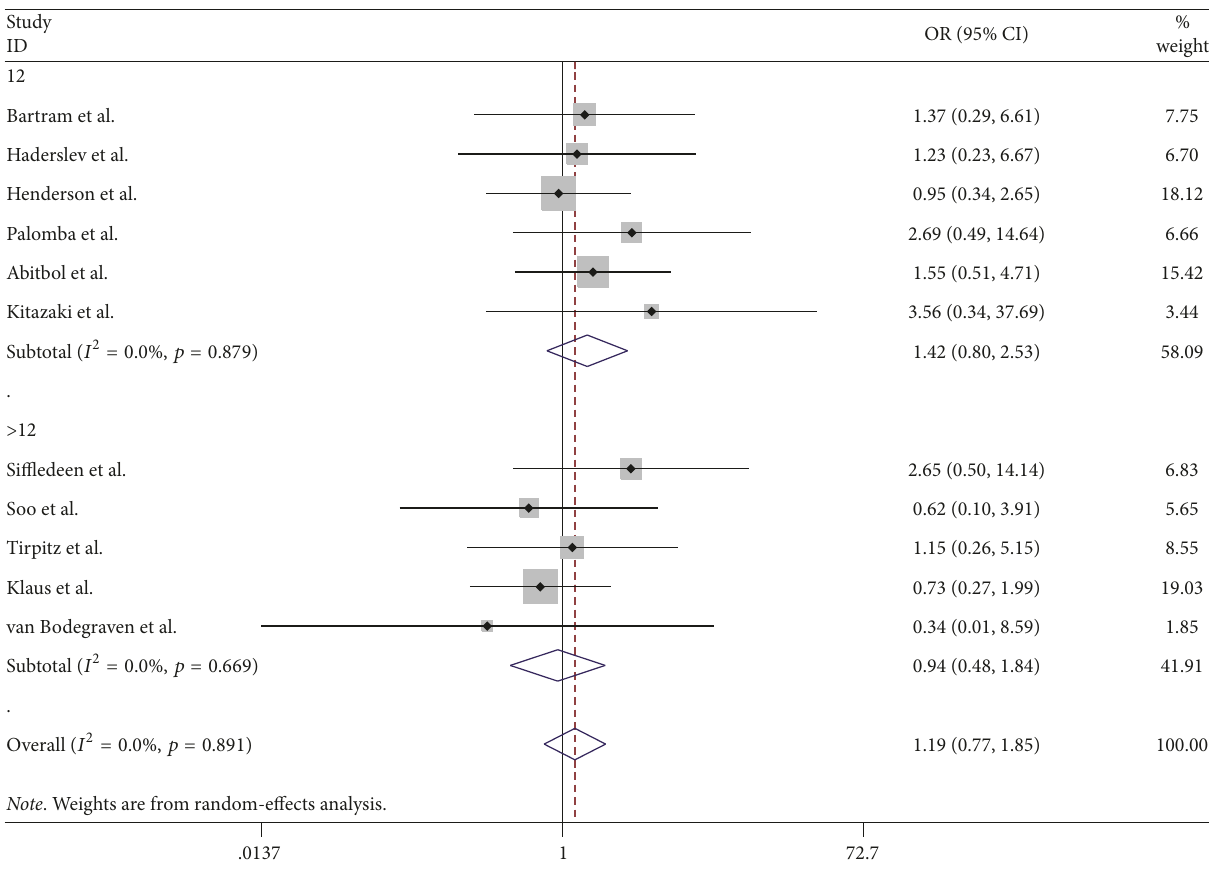
Figure 6: Randomized controlled trials of bisphosphonates in adverse events. Forest plot showing the odds ratio and 95% confidence interval of the adverse event rates.